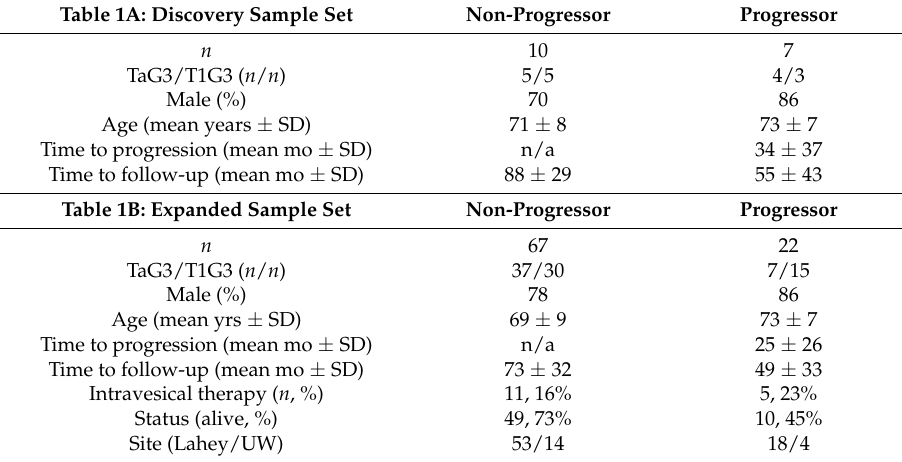
Table 1. Clinical profile of patients. 1A: discovery sample set used in the microarray analysis and the initial qRT-PCR validation. 1B: expanded sample set of patients used in qRT-PCR analysis. mo = months; SD = standard deviation; UW = University of Wisconsin.